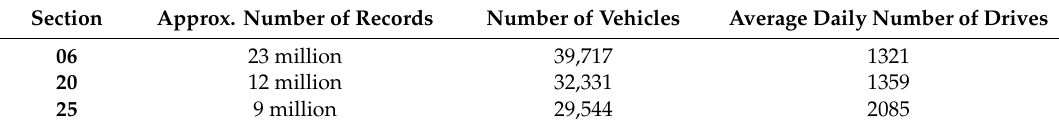
Table 3. Summary characteristics of collected floating car data